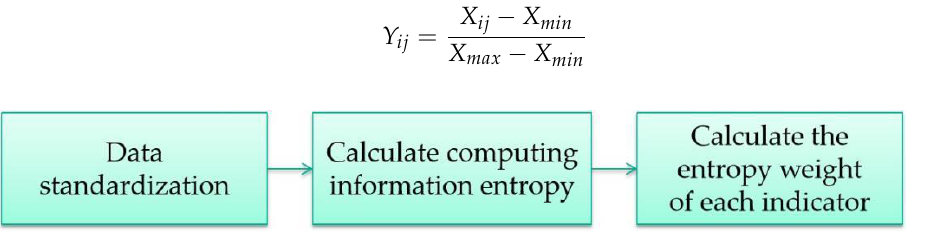
Figure 2. The basic steps of the entropy weight method.